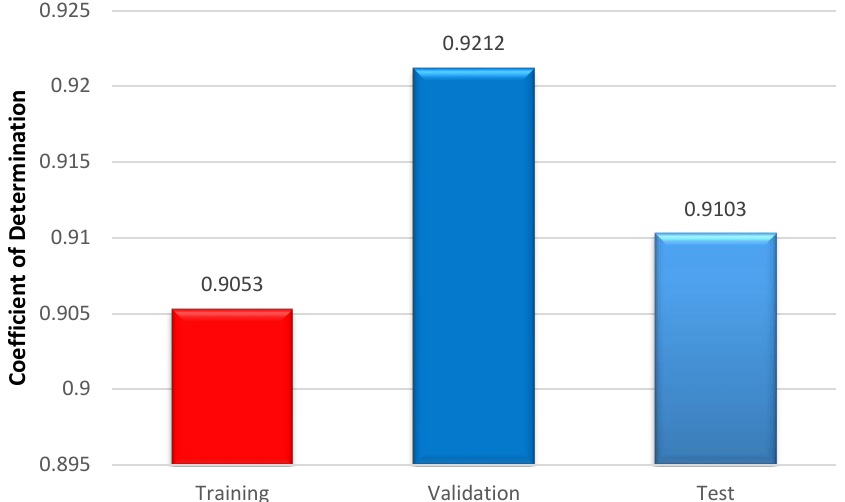
Fig. 5. The coefficient of determinations for training, check, and test